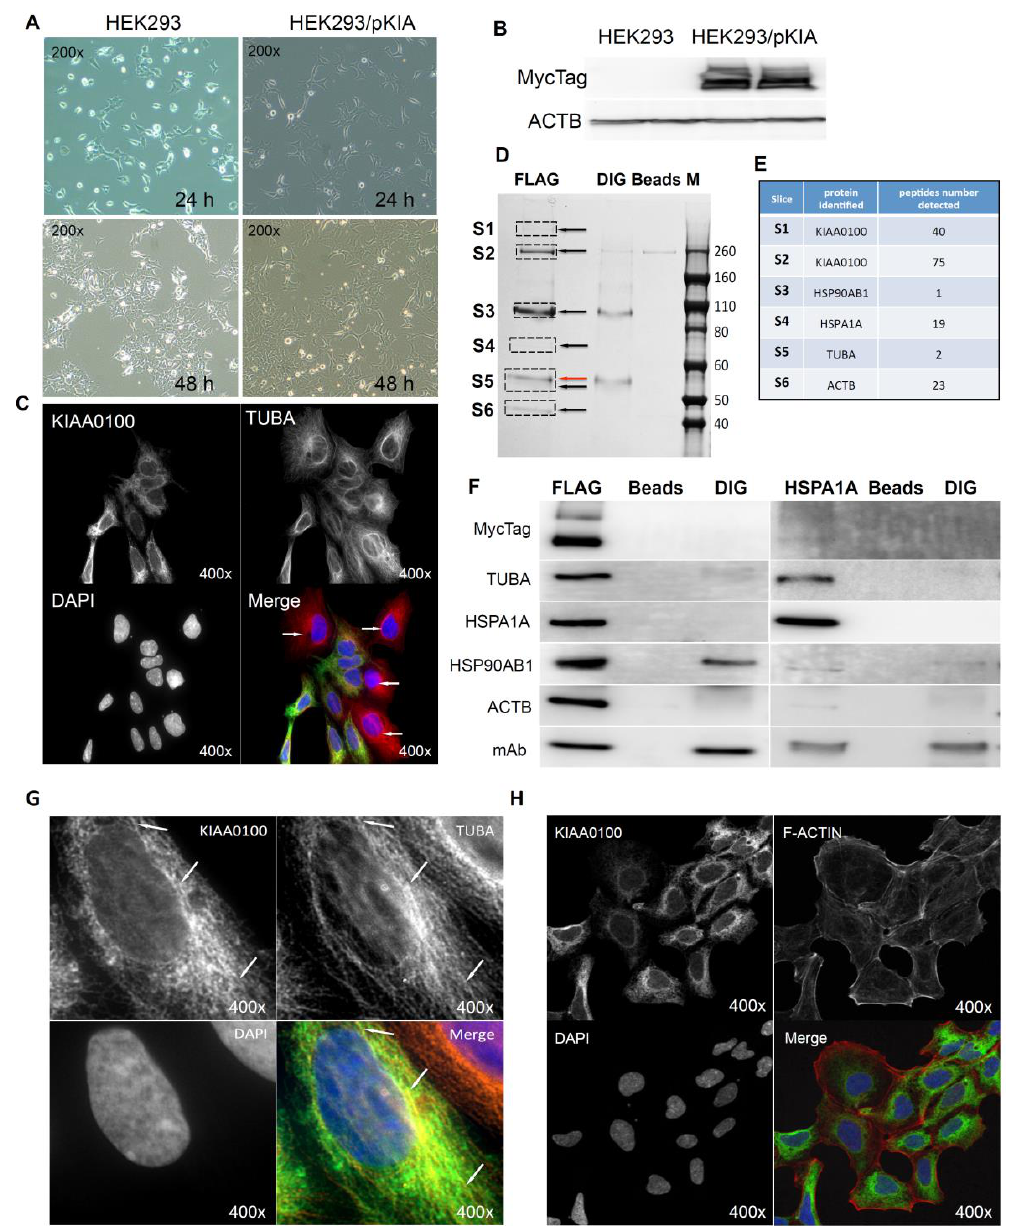
Figure 6 . Cont. Figure 6.